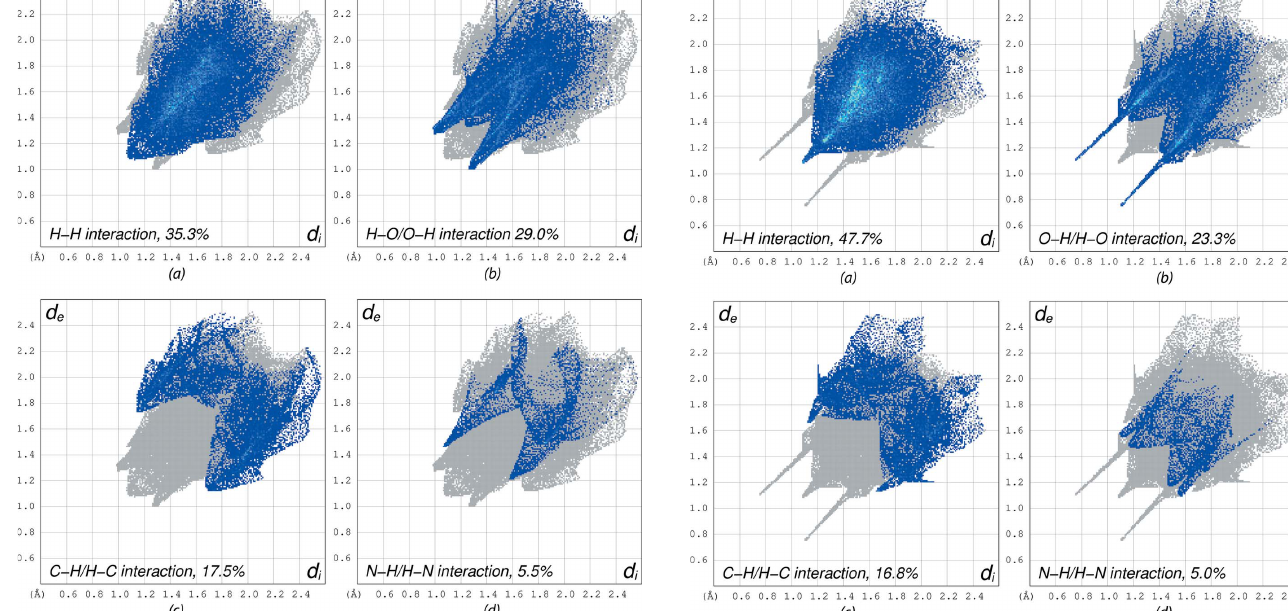
Figure 9 The two-dimensional fingerprint plots for (V) delineated into ( a ) H (cid:3)(cid:3)(cid:3) H contacts, ( b ) O (cid:3)(cid:3)(cid:3) H/H (cid:3)(cid:3)(cid:3) O contacts, ( c ) C (cid:3)(cid:3)(cid:3) H/H (cid:3)(cid:3)(cid:3) C contacts, and ( d ) N (cid:3)(cid:3)(cid:3) H/H (cid:3)(cid:3)(cid:3) N contacts. Other contact contributions less than 5% are